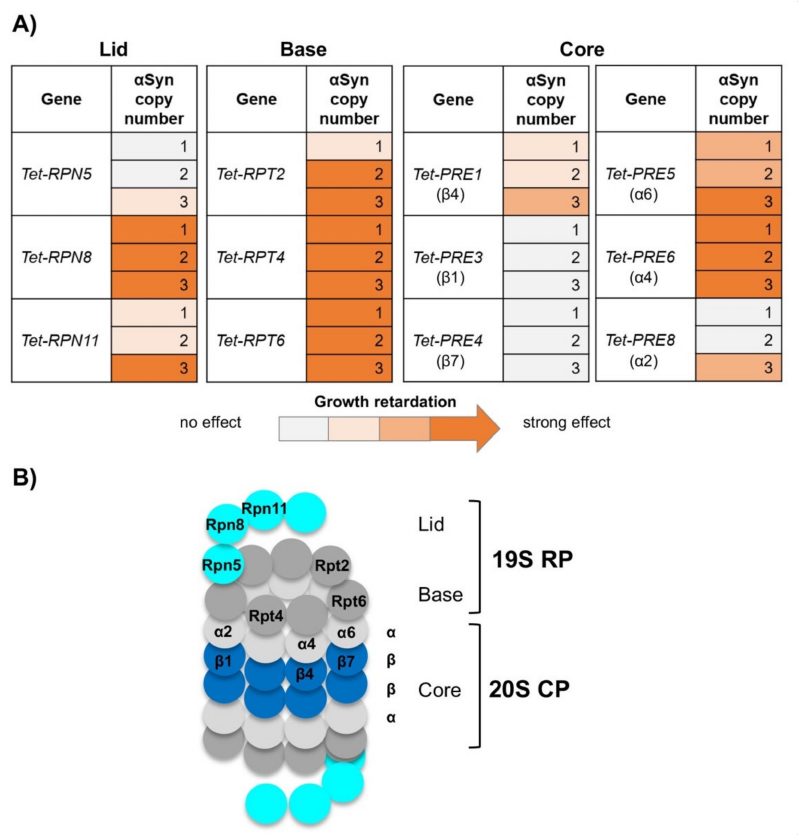
Figure 4. Downregulation of the gene expression of multiple proteasome subunits significantly enhances α Syn toxicity. ( A ) Heatmap representing the genetic interactions upon downregulation of the proteasome genes and α Syn expression. A strong synthetic sick phenotype was observed upon downregulation of multiple proteasome subunits genes. The strongest response was detected upon downregulation of the lid and base subunits. The growth inhibition increased with increasing dose of α Syn. ( B ) Schematic structure of the yeast 26S proteasome, consisting of the 19S regulatory particle (RP) and 20S core particle (CP). The proteasome subunits from ( A ) are indicated within the structure.